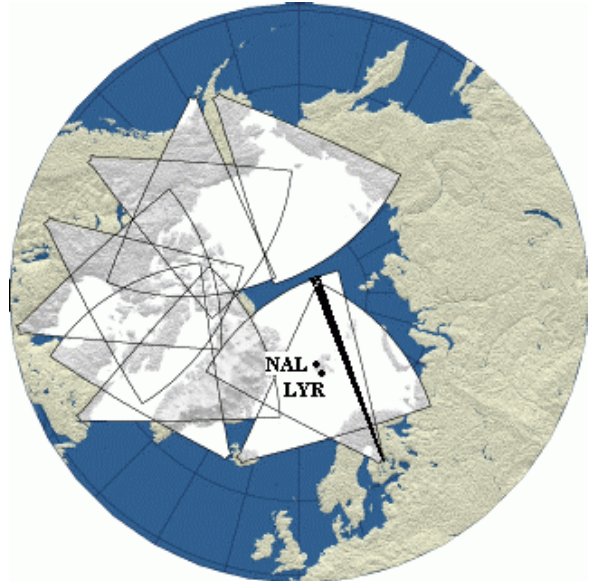
Fig. 1. Northern Hemisphere SuperDARN. The Hankasalmi radar beam 13 and a magnetometer sites at Ny ˚Aleslund (NAL) and Longyearbyen (LYR) are